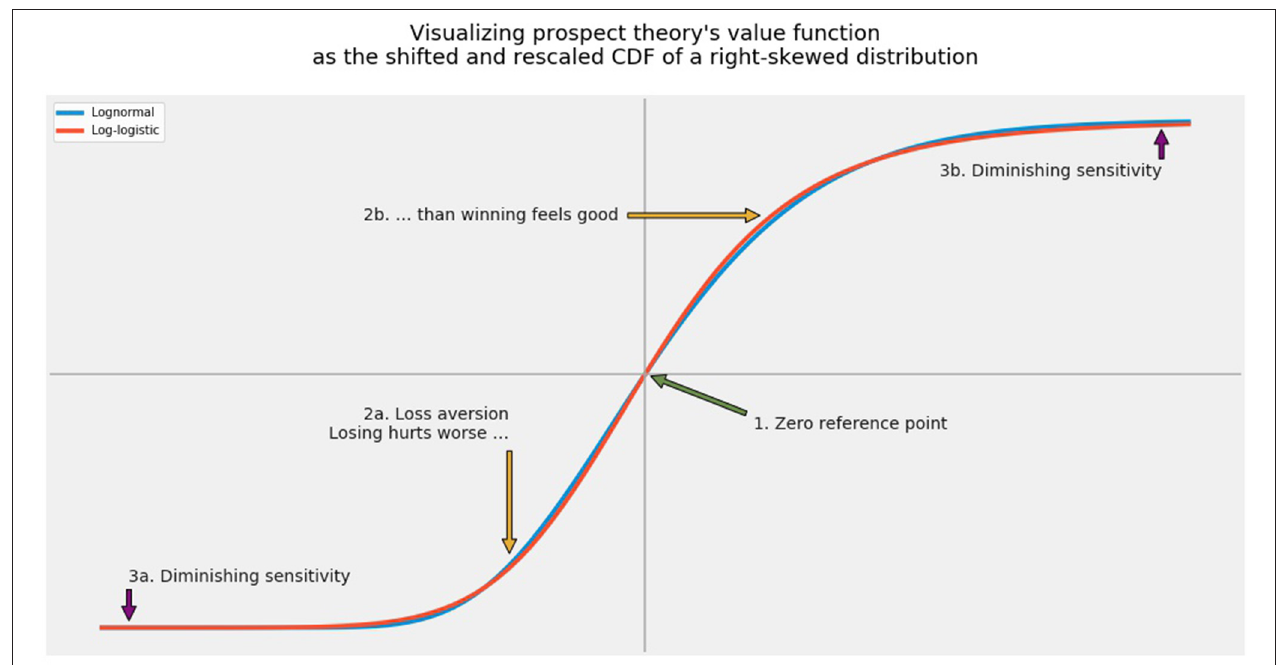
FIGURE 1 | Visualizing prospect theory as the cumulative distribution function of a right-skewed probability